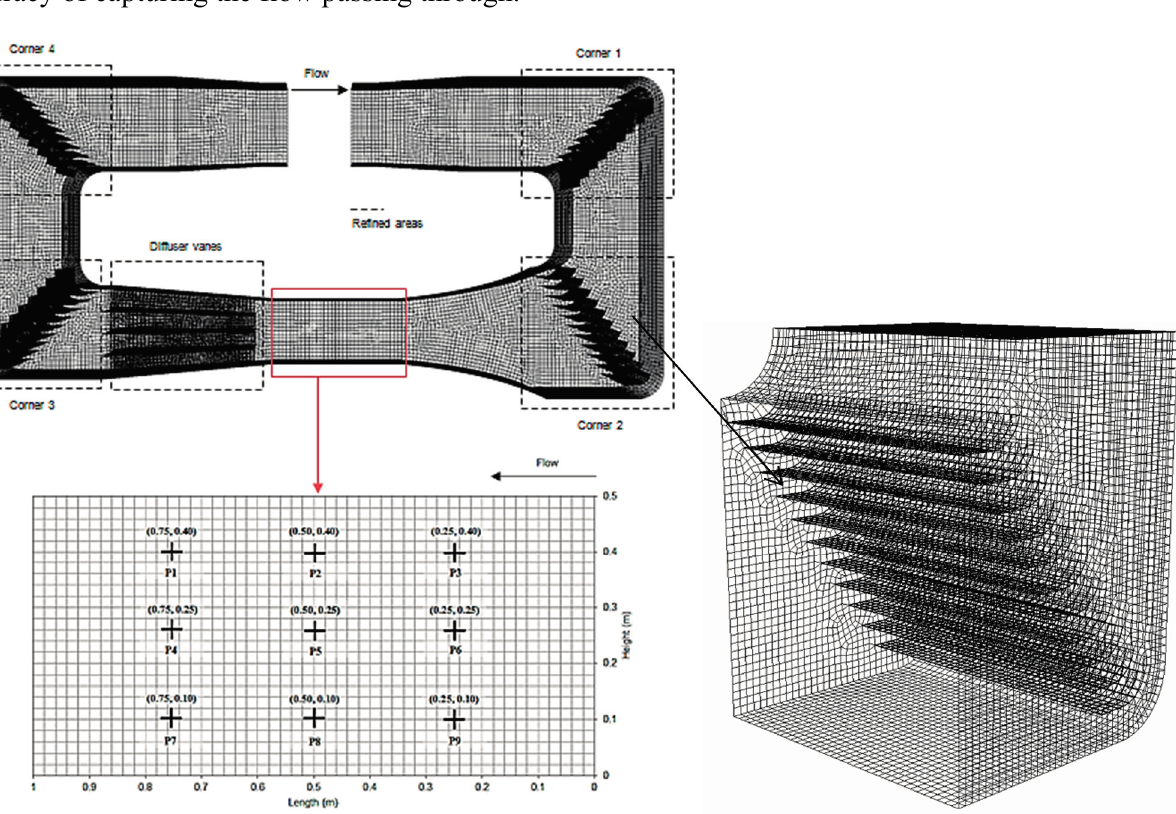
Figure 4. Grid design highlighting areas of refinements and the measurement